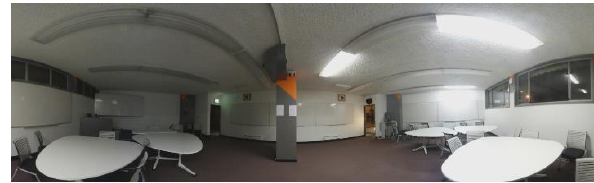
Figure 5. Scenario 1 setup panoramic view